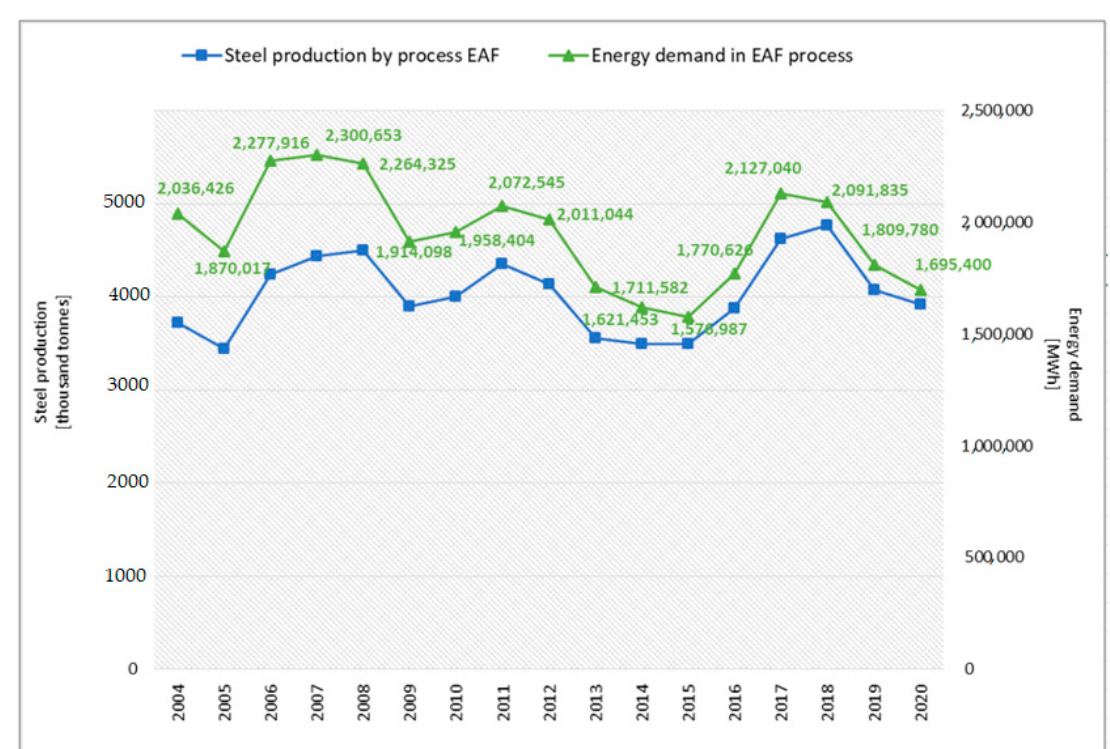
Figure 11. Total energy demand in the EAF process in Poland from 2004 to 2020. Source: Own elab- oration.